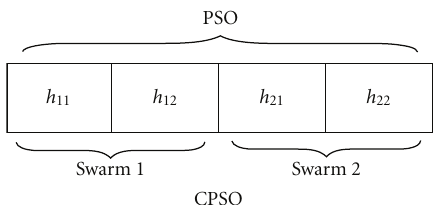
Figure 1: Possible separation of an 8-dimensional problem into a set of lower-dimensional problems by the CPSO compared to PSO.